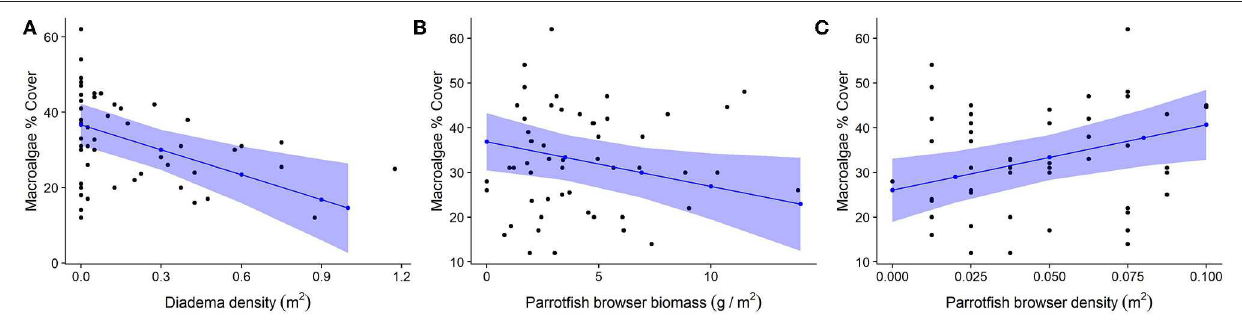
FIGURE 7 | Relationship between herbivores and macroalgae cover. For all plots, black dots represent raw data points, blue dots and lines represent unscaled model estimates and 95% confidence intervals from the final model. (A) Negative association between Diadema density and macroalgae; (B) Negative association between parrotfish browser species biomass and macroalgae; (C) Positive association between parrotfish browser density and